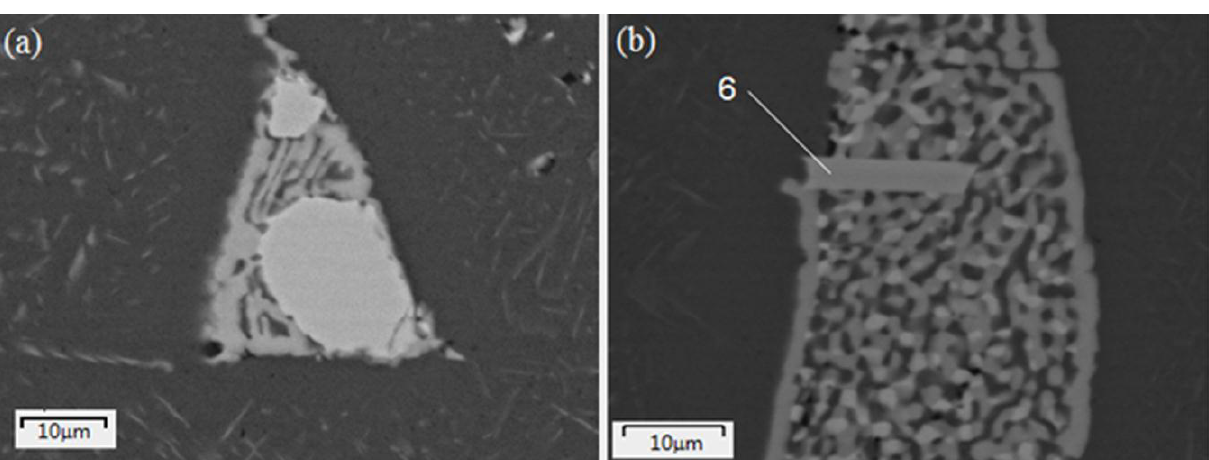
Figure 3. The morphologies of eutectic cellular: ( a ) eutectic α-Al + Al 2 CuMg; ( b ) eutectic α -Al + Al 2 Cu + Al 2 CuMg.